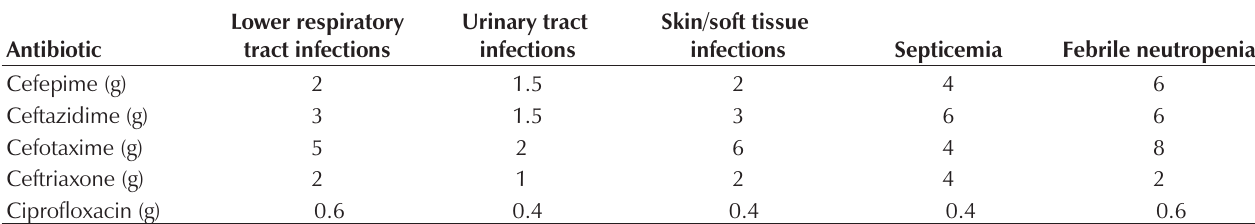
Total daily antibiotic dose by infectious disease Antibiotic